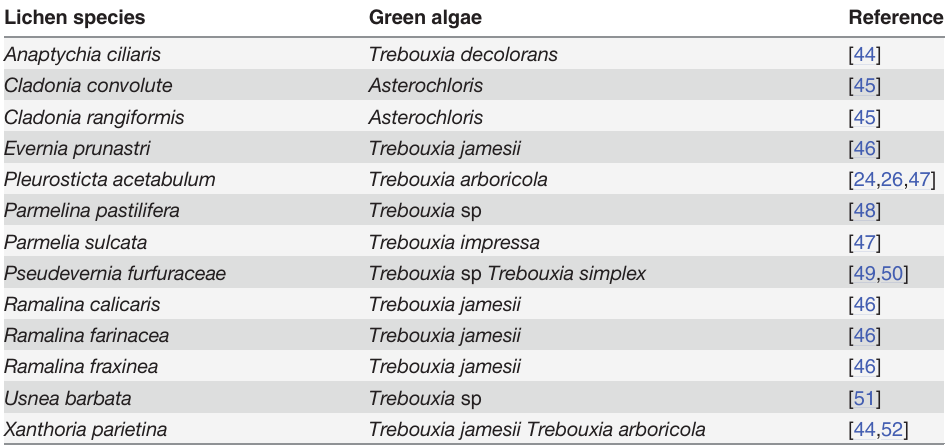
Table 1. Green algae as symbiotic photobionts in the studied lichen